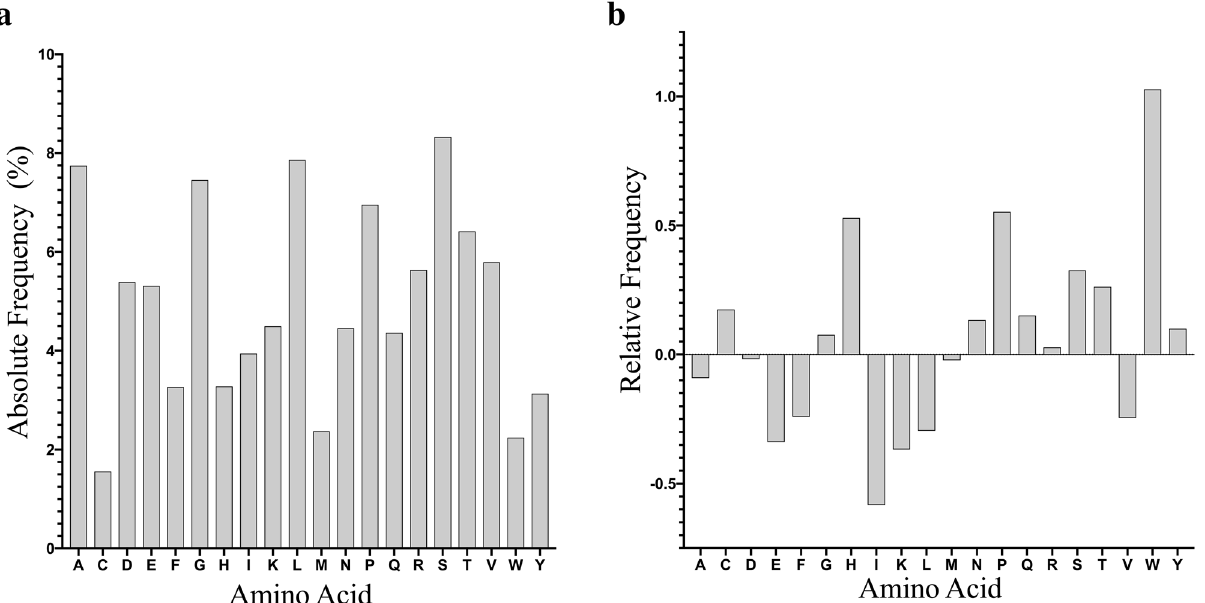
Figure 1. Absolute and relative amino acid frequencies in B-cell epitopes. ( a ) Figure shows the frequency in percentage (Y axis) of each of the 20 distinct amino acids (X axis) in B cell epitopes included in BEPIBD. ( b ) Figure represents the same amino acid frequencies but relative to those in SWISSPROT, represented as log2 values. Negative